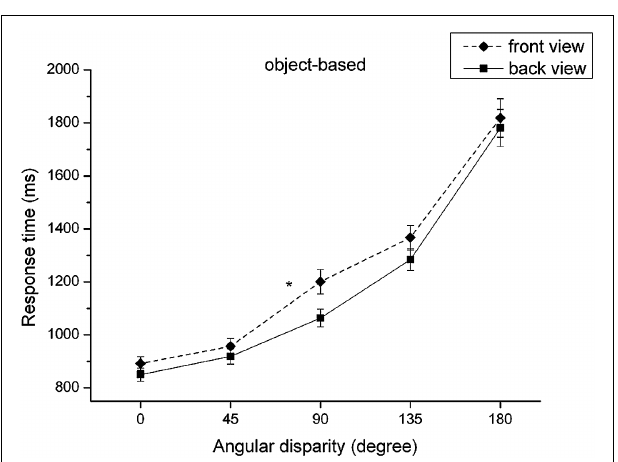
FIGURE 5 | Reaction time (mean and SE) dependent on view and group for egocentric transformations. * p <